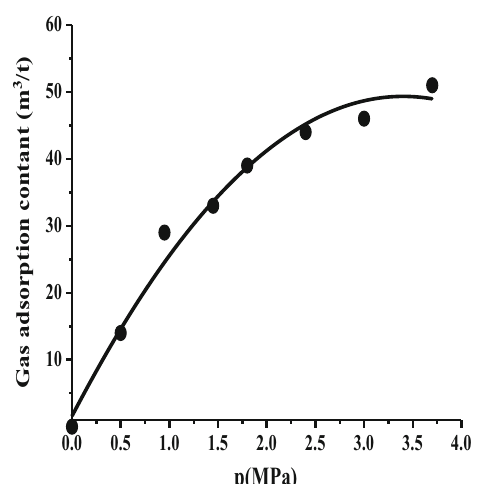
Fig. 10 p = Q – p and adsorption constant of number 5